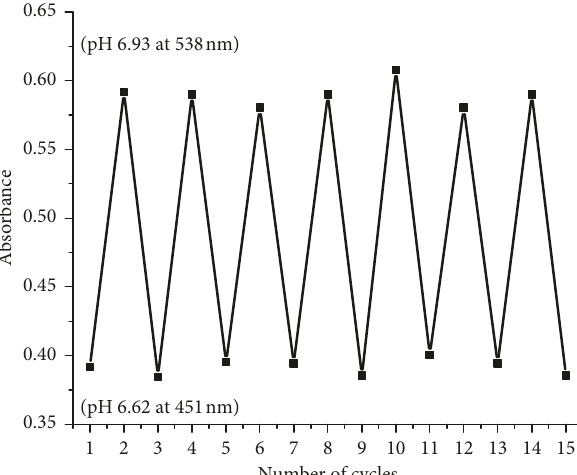
Figure 4: Variations in the ratio of the absorbances at 451 and 538nm of 1 in acetonitrile ( ca. 2.3 × 10 − 5 mol · L − 1 ) while shifting pH values back and forth between 6.62 and ∼ 6.93.